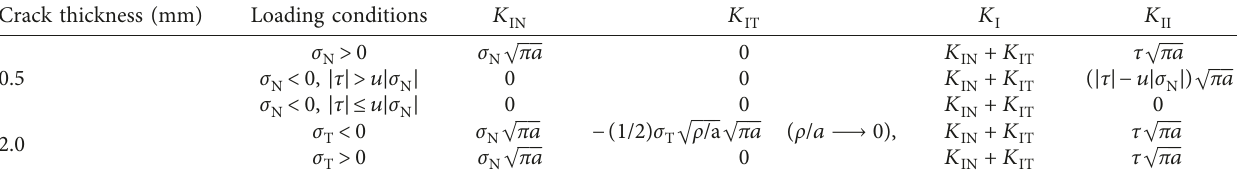
Table 1: SIFs for closed and nonclosed